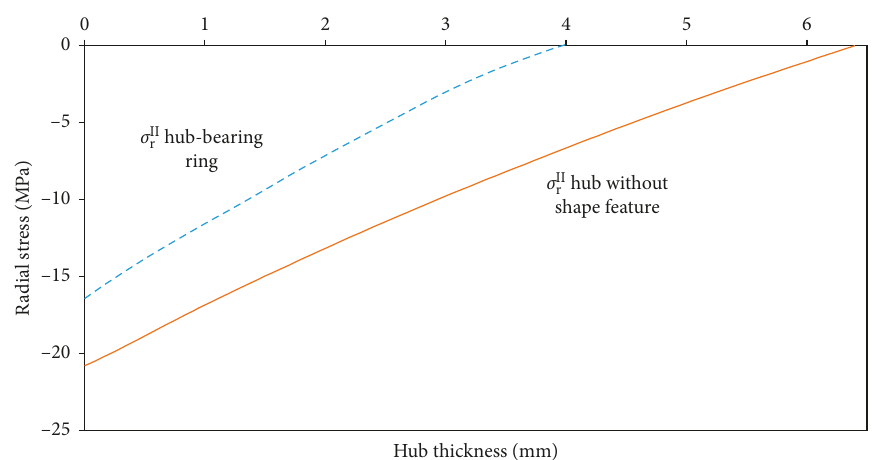
Figure 9: Radial stress (hub) comparison.